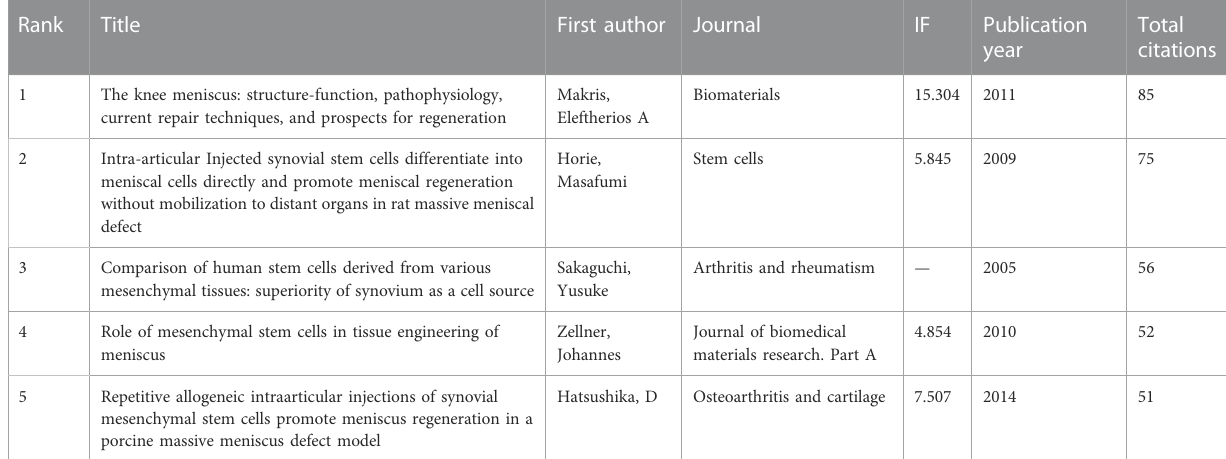
TABLE 7 The top 5 cocitation analyses of cited references on stem cells for meniscal regeneration. Rank